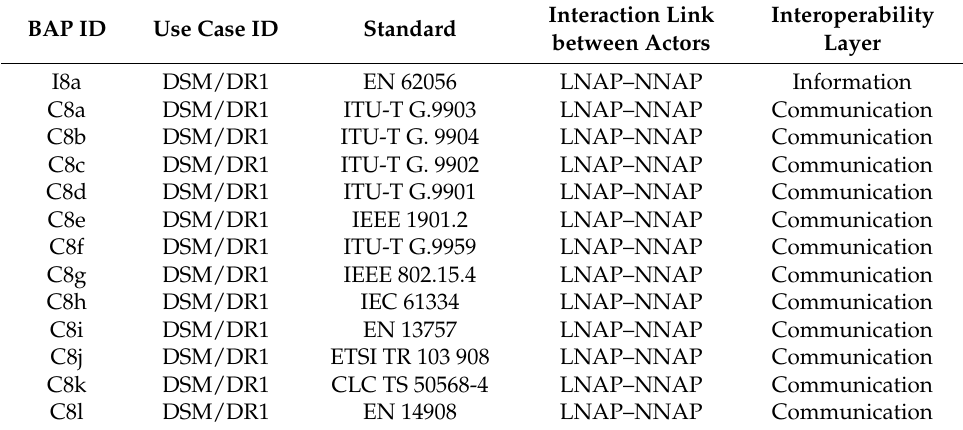
Table 8. Possible BAPs for the equipment under test.